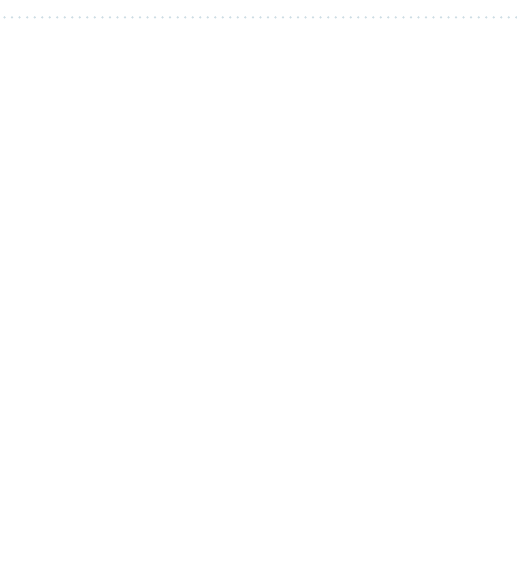
Table 4. Comparison of numerical study regarding − θ( 0 ) with published work 48 when Ec = 0, H t = 0, m = 0, ϕ 1 = 0 ϕ 2 = 0 ϕ 3 = 0.